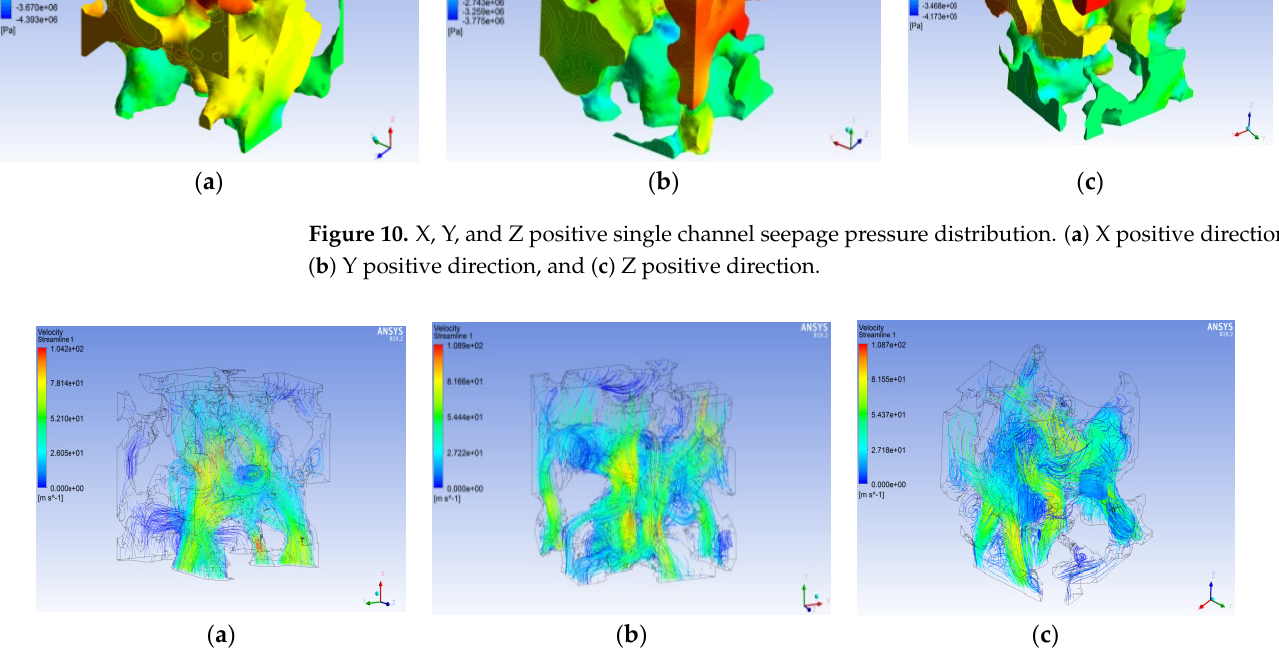
Figure 11. Streamline diagram of X, Y, and Z positive single channel seepage velocity distribution.